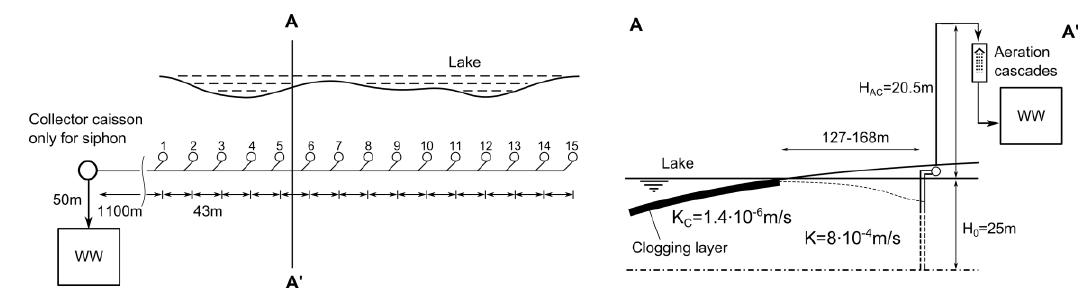
Figure 3. Schematic of the fictional lake bank filtration site with 15 wells.